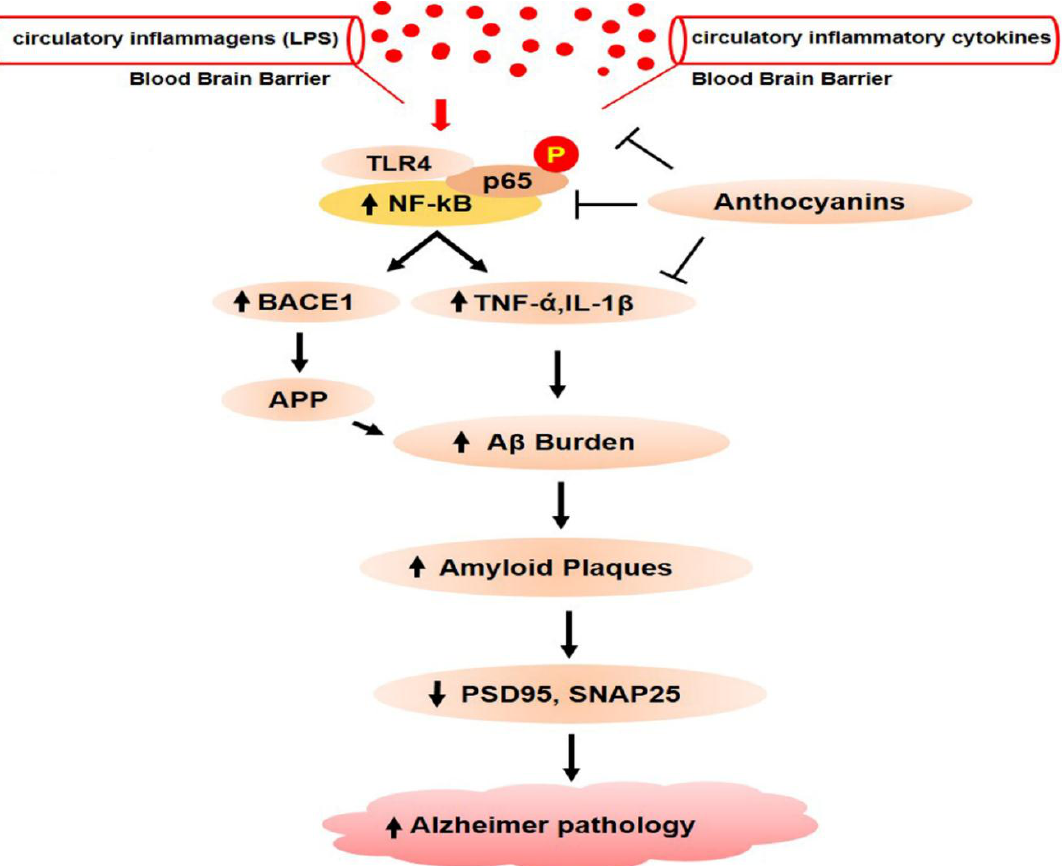
Figure 7. Anthocyanins prevent inflammatory and amyloid genic pathways in the central nervous system. When circulatory lipopolysaccharides and inflammatory cytokines gain entry to the brain, toll-like receptor 4 on microglia is activated, which subsequently leads to the activation of nuclear factor kappa B (NF- κ B). After NF- κ B phosphorylation and translocation to the nucleus, it goes on to bind with proinflammatory cytokine genes, that results in the production and release of proinflammatory cytokines. NF- κ B also binds with the promoter region of BACE1 that produces β -secretase enzymes. Increased BACE1 activities later result in abnormal APP cleavage. Chronic deposition of amyloid beta proteins in the brain causes amyloid beta plaque formation and neuronal cell death. Amyloid beta plaques also deregulate pre- and postsynaptic proteins, which results in dementia and memory impairment.